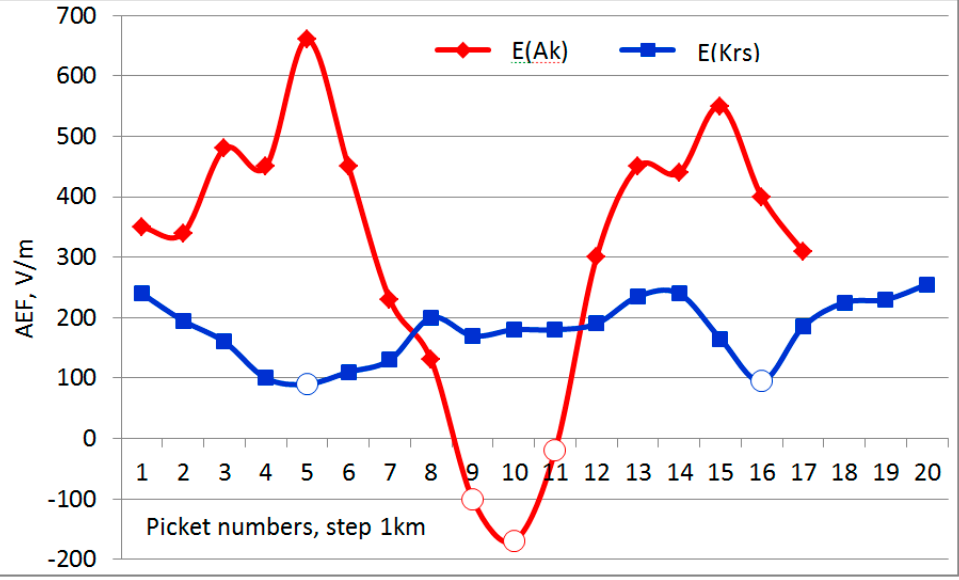
Figure 4. Variations AEF in faults zones: Aktash River area E(Ak), Dagestan; Kaluga ring structure